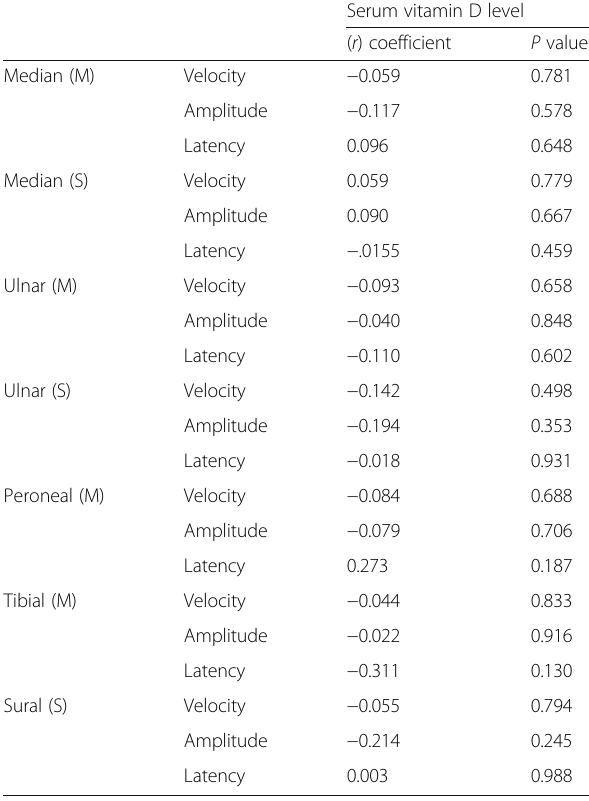
conduction study